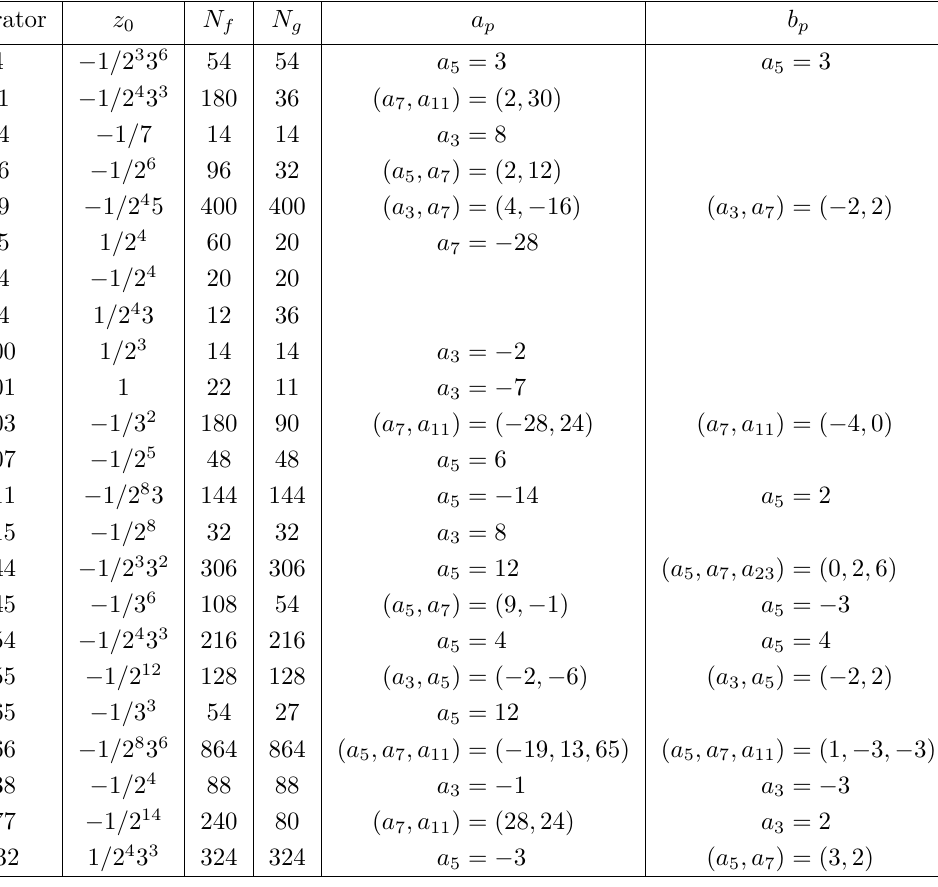
Table 1 . Some rational rank two attractor points of Calabi-Yau operators. The labels corresponds to the number in [22] and in the last case to the number from [57]. We give enough Hecke eigenvalues a p and b p to specify the associated normalized Hecke eigenforms f ∈ S 4 (Γ 0 ( N f )) new and g ∈ S 2 (Γ 0 ( N g )) new